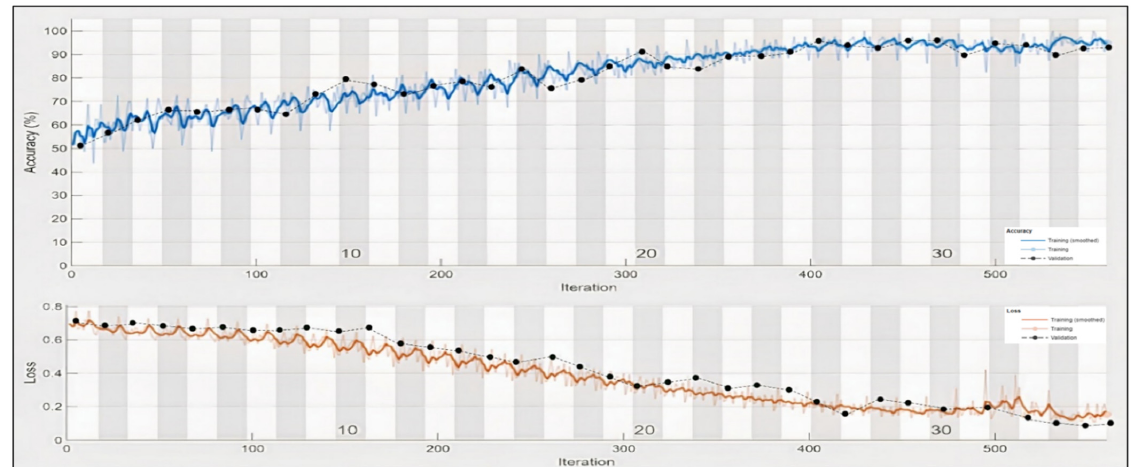
Figure 19. Training progress of Arousal label.